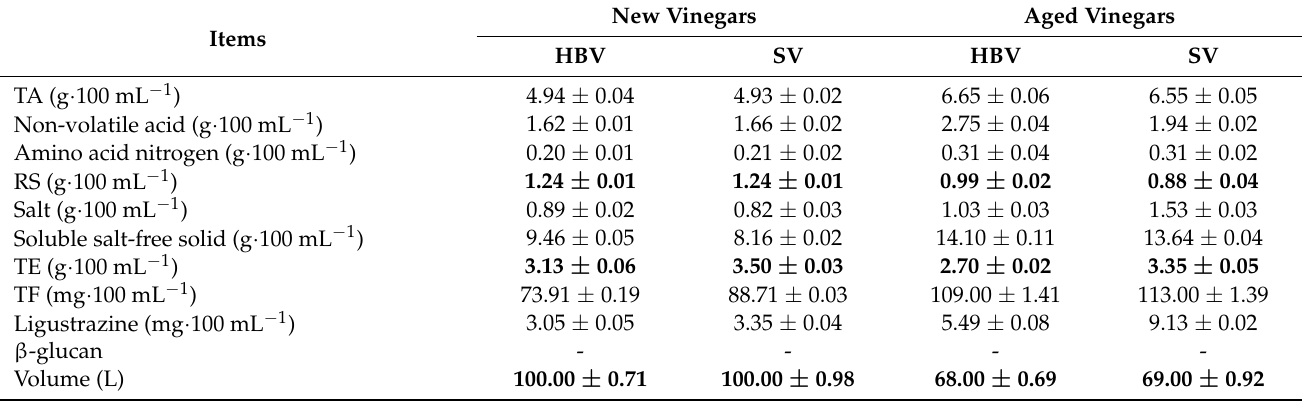
Table 3. The main composition in HBV and SV before and after aging.